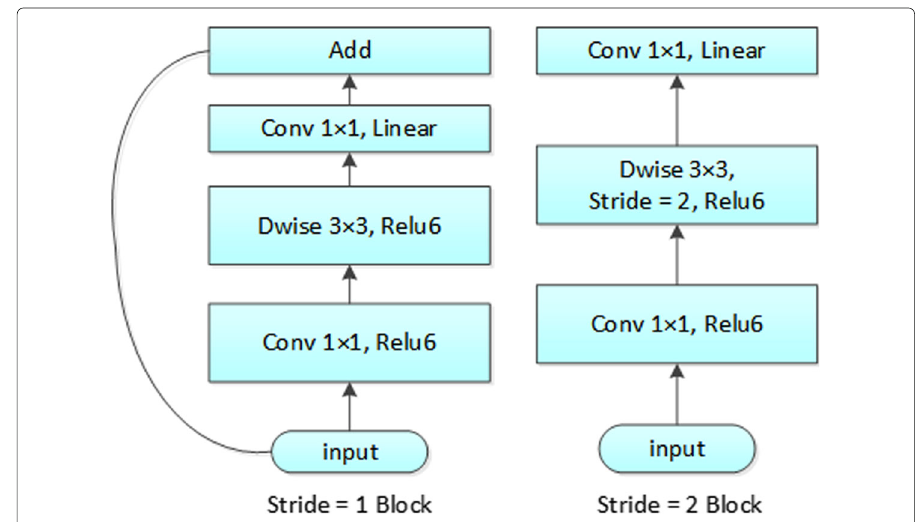
Fig. 2 Linear bottlenecks + inverted recurrent block